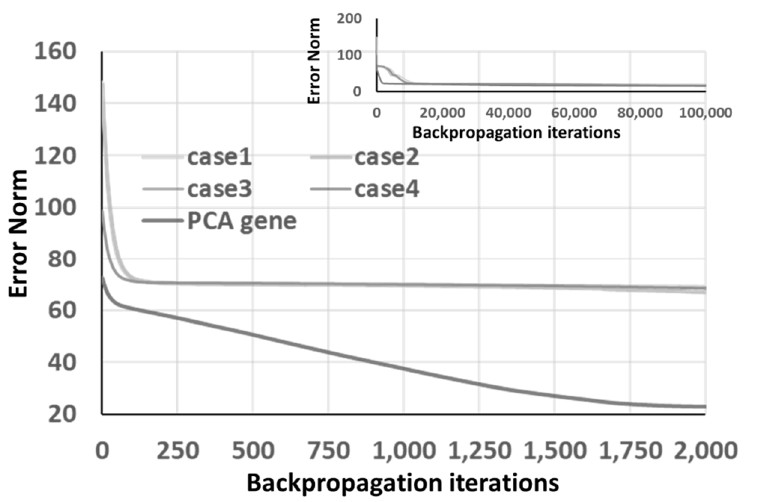
Figure 16. The convergence of 4 GA “back-to-original” optimized chromosomes and PCA gene under RNN architecture.